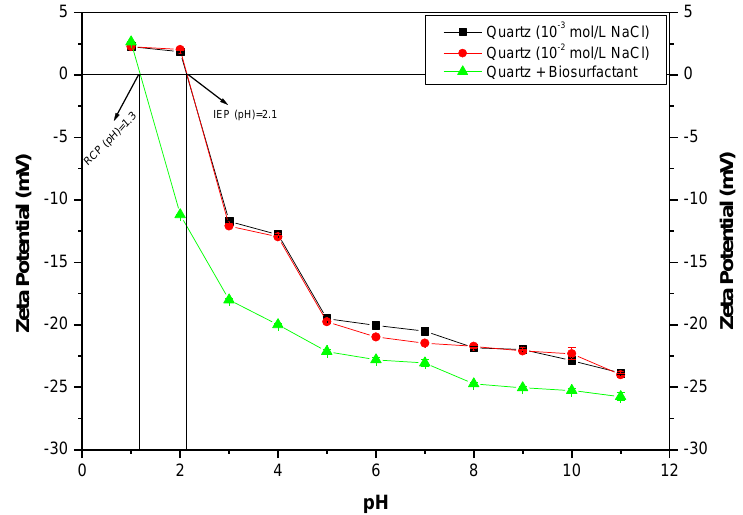
Figure 8. Zeta potential profile of quartz, before and after interaction with biosurfactant (300 mg/L).